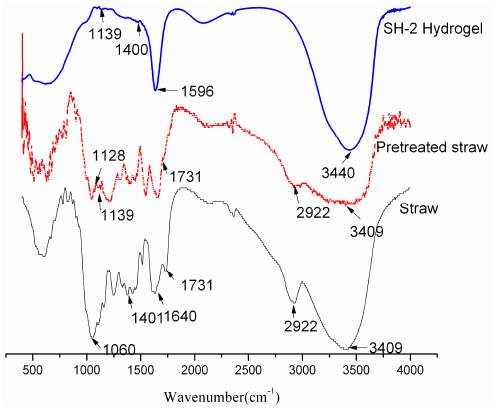
Figure 1. FTIR of straw, pretreated straw and hydrogel.